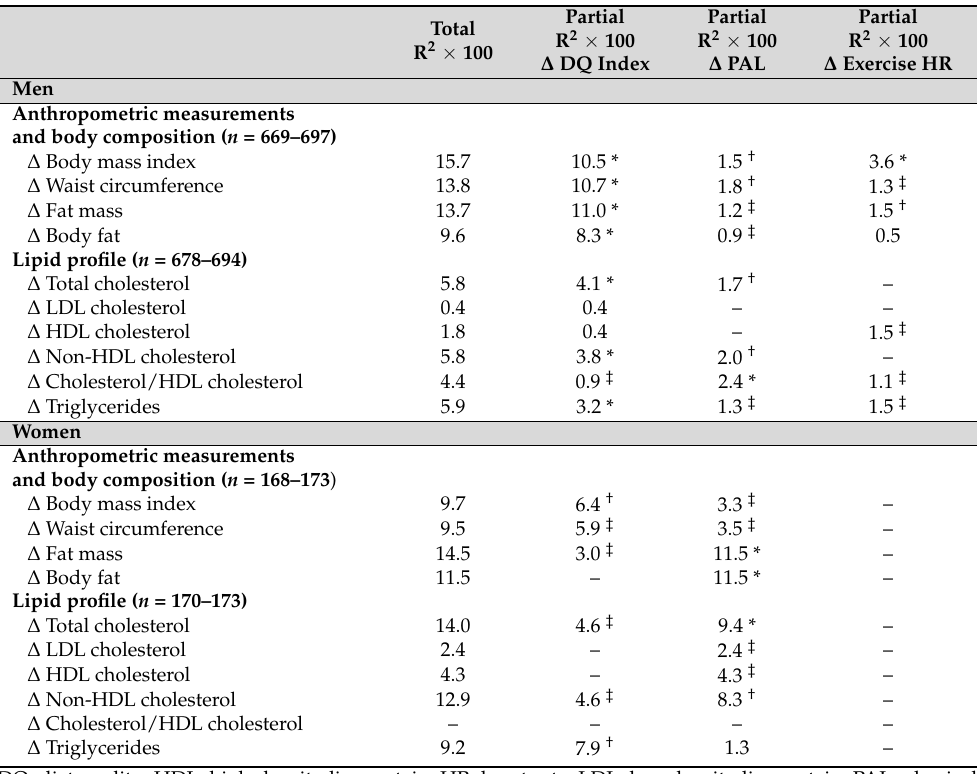
Figure 3. Standardized regression coefficients (with 95% confidence intervals) for the association between changes in diet quality index or physical activity level and changes in cardiometabolic risk markers in men and women. Models are adjusted for medication use (lipids, hypertension, and diabetes) and menopausal status in women. HDL: high-density lipoprotein. Table 4. Multiple linear regression models showing the independent associations of changes in diet quality index, physical activity level, and exercise heart rate on changes in cardiometabolic